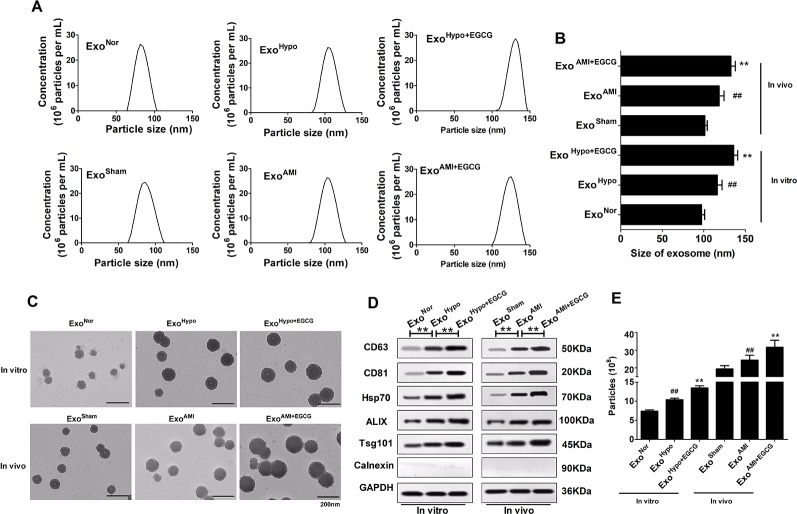
Preparation and characterization of exosomes secreted by cardiomyocytes in vitro and in vivo. (A, B) Representative graph of exosome concentration (E6 particles/mL) and size distribution of exosomes as measured by nanoparticle tracking analyses (NTA). ##
p < 0.01 vs. sham (normoxia) group; **p < 0.01 vs. AMI (hypoxia) group. (C) Representative images of exosomes released by cardiomyocytes visualized by TEM. Scale bars: 200 nm. (D) Representative images of western blotting to assess the presence of enriched proteins and calnexin in exosomes lysates. (E) The exosome concentrations in vitro and in vivo were recorded by NTA. Values were expressed as mean ± SD (n = 6). ANOVA testing was performed; **p < 0.01 vs. other group.